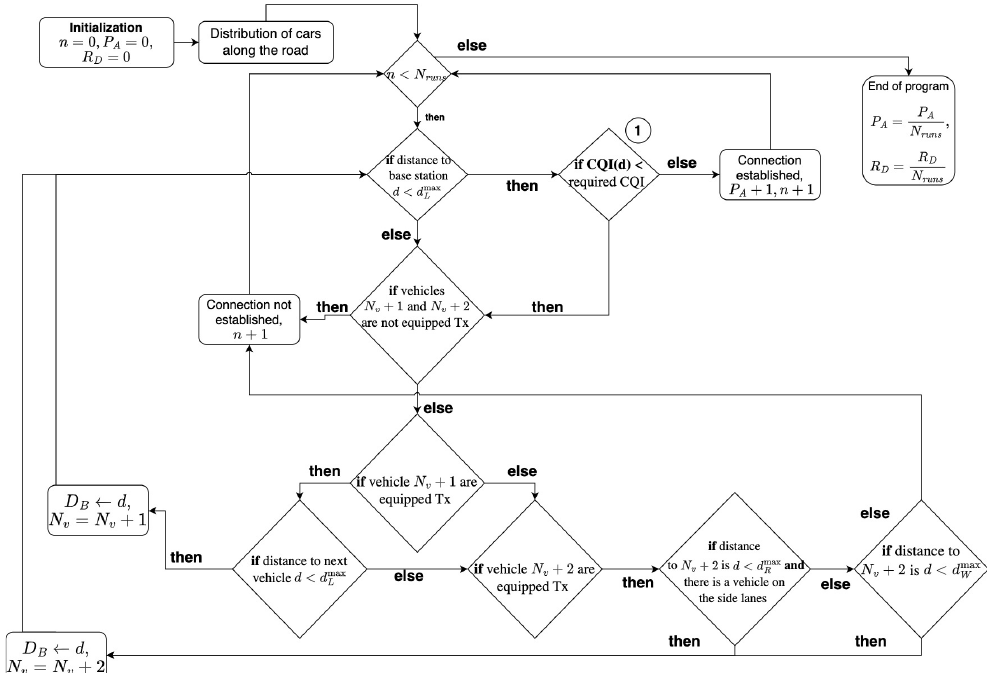
Figure 3. Simulation algorithm of establishing relaying communication.